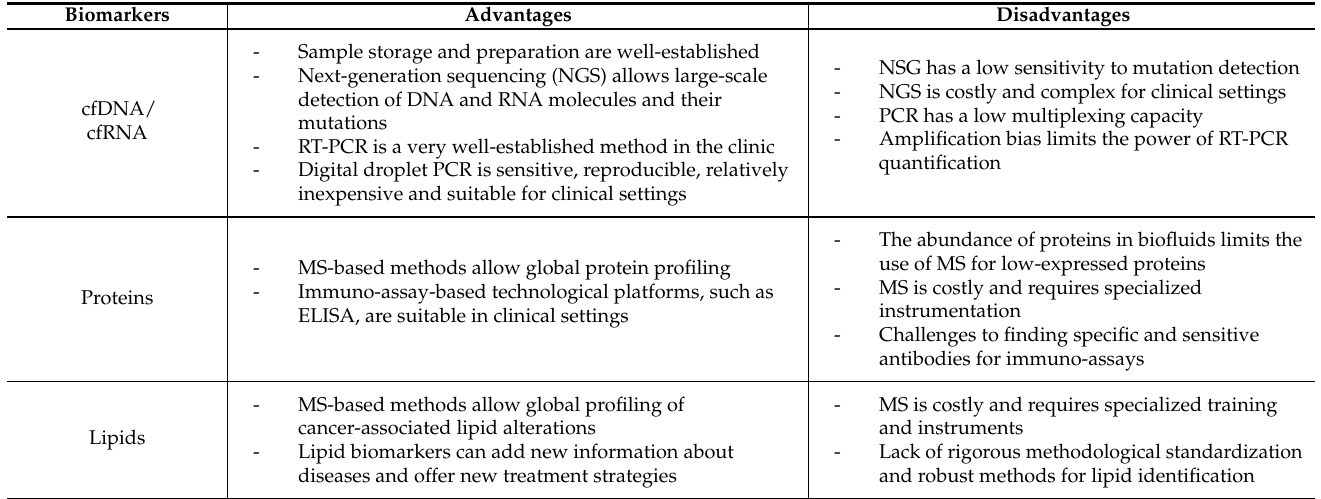
Table 2. Comparison of the advantages and disadvantages of lipid biomarkers versus protein- and nucleic acid-based biomarkers for their potential use in clinical settings. It should be noted that these advantages and disadvantages are dependent to a large extent on the technology platform used. Therefore, the development of more reliable and easy-to-use technologies can change the current view on the pros and